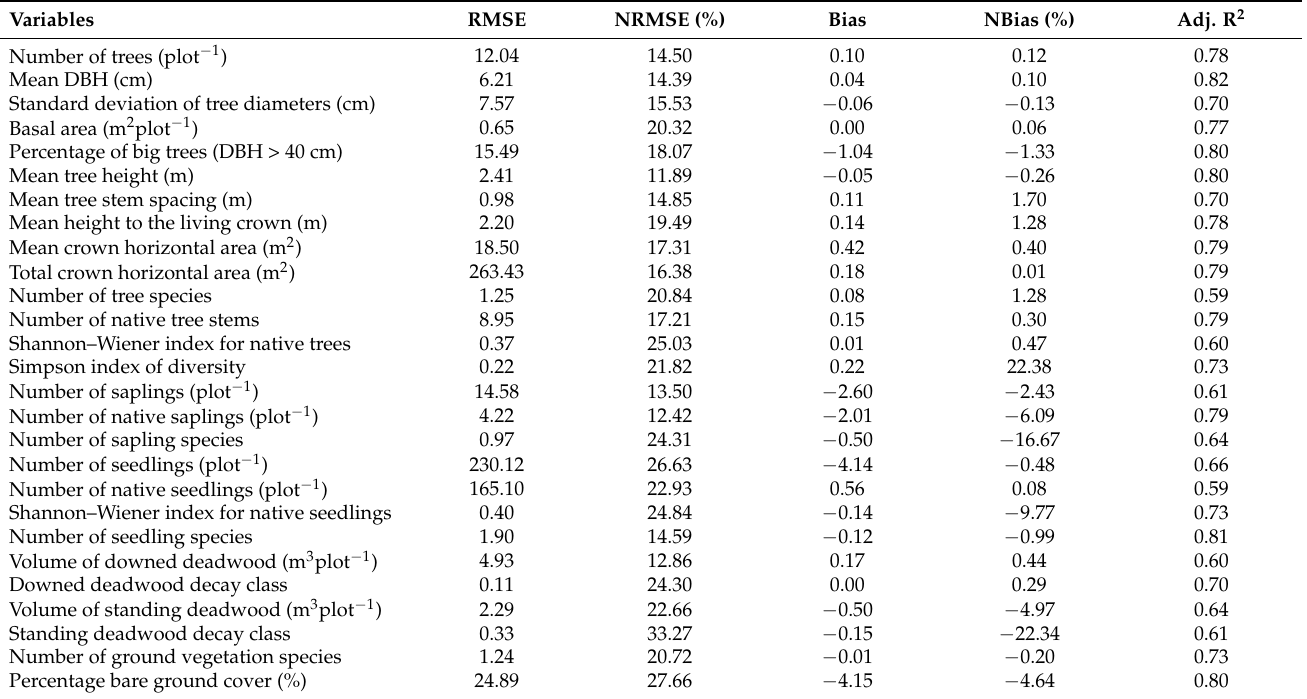
Table 2. Summary statistics of each random forest model using metrics from the leaf-on acquisition, with absolute and normalised root mean square error (RMSE and NRMSE); absolute bias and normalised bias (NBias); and the adjusted coefficient of determination (Adj. R 2 ).